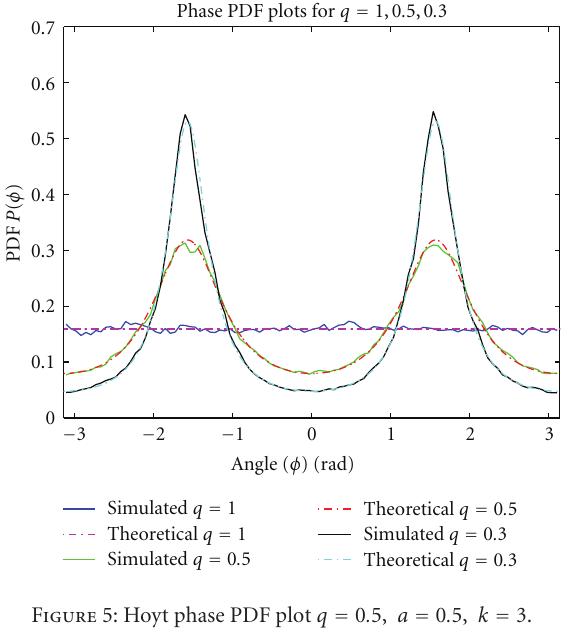
Figure 5: Hoyt phase PDF plot q = 0 . 5, a = 0 . 5, k = 3.